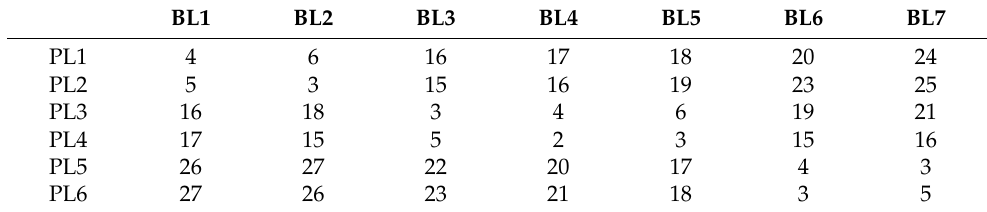
Table 6. The transportation energy consumptions per unit product